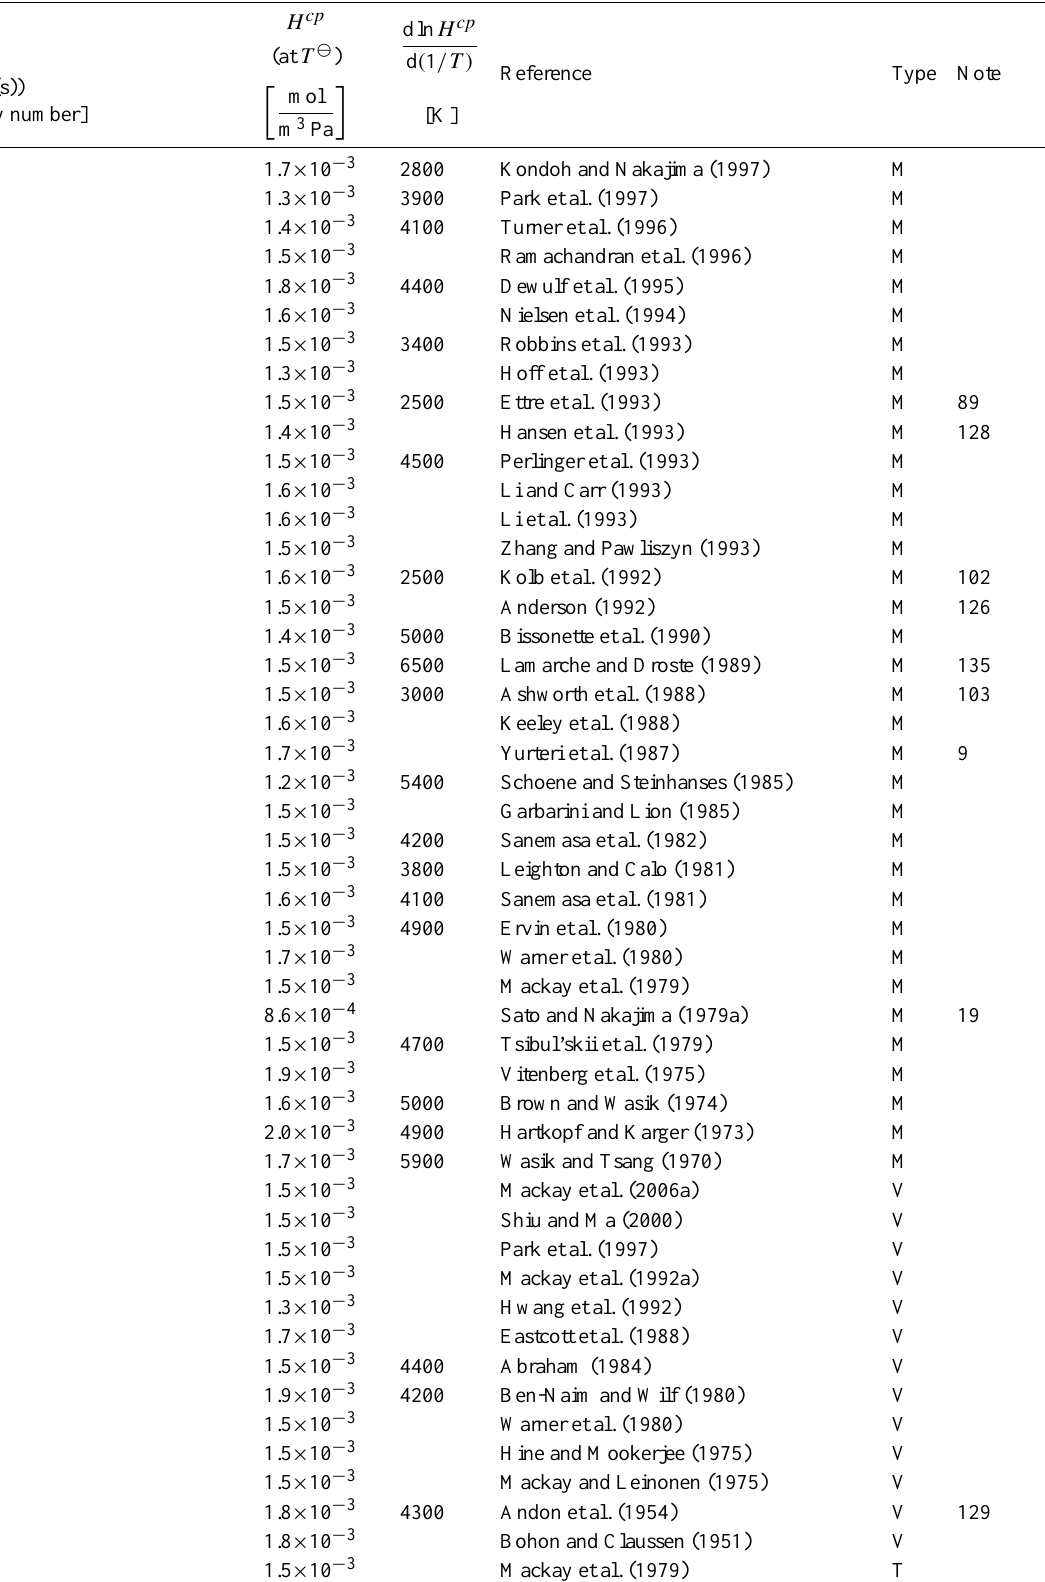
Table 6: Henry’s law constants for water as solvent